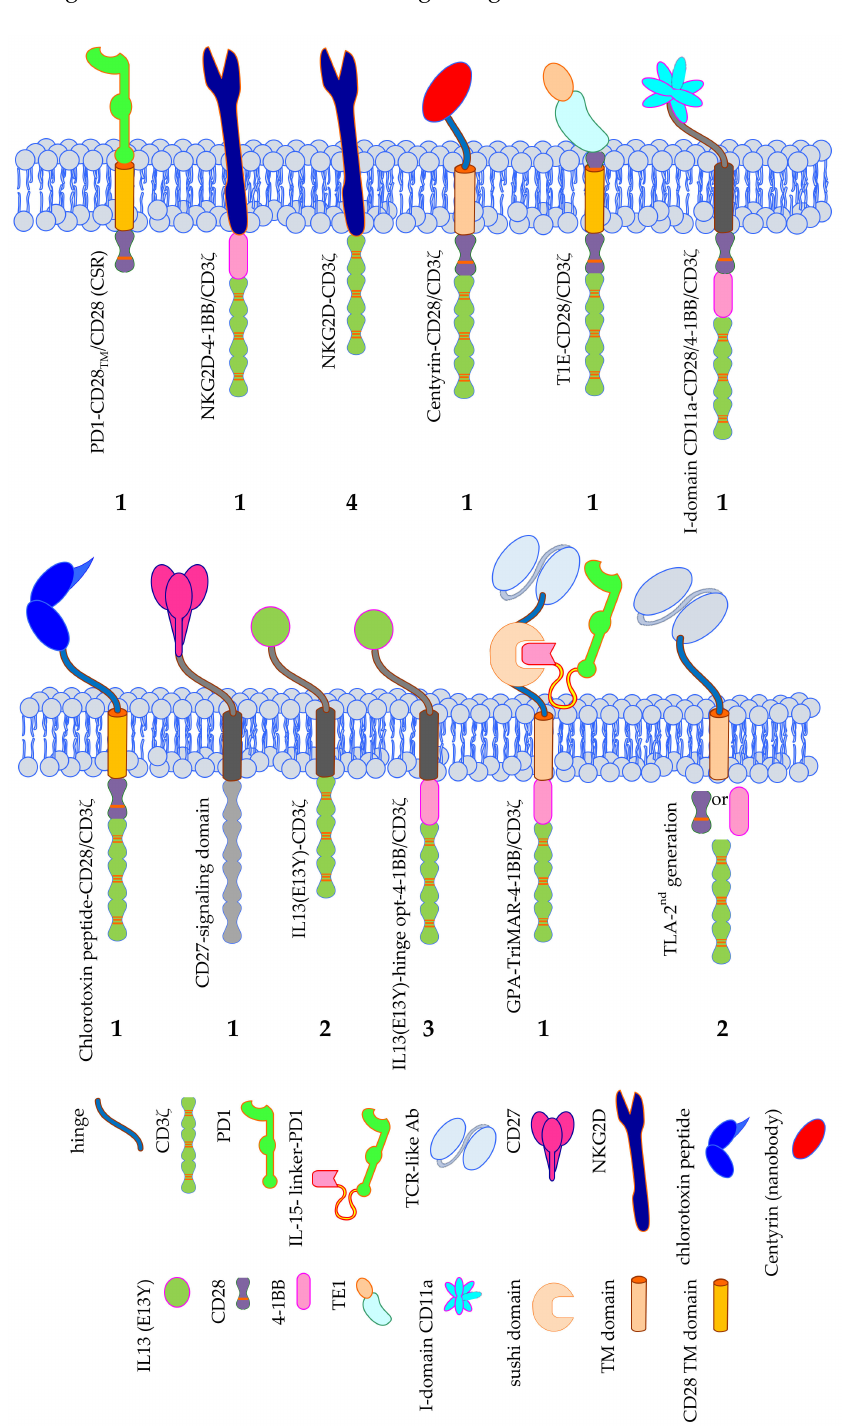
Figure 6. Schematic overview of the exotic CAR formats used in clinical trials treating solid tumors. The number of clinical trials using a specific CAR format is indicated. Data was extracted from clinicaltrials.gov. TM = transmembrane domain, PD1 = programmed cell death protein 1, IL13